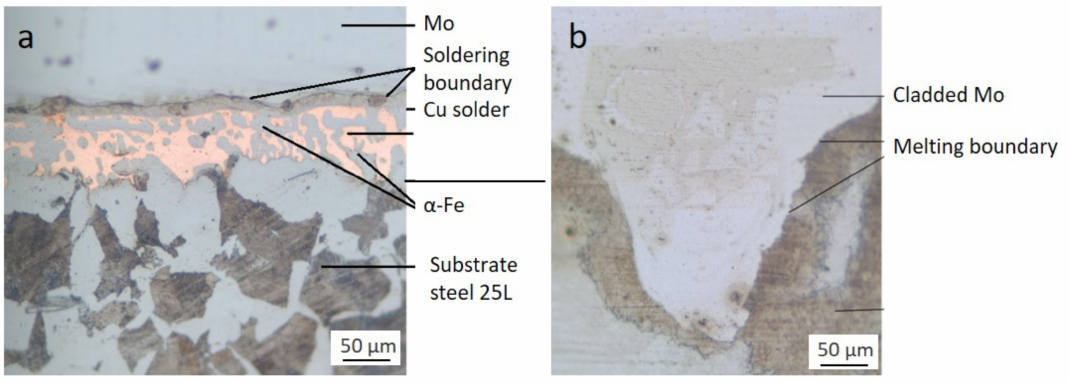
Figure 8. ( a ) Seam microstructure in vacuum brazing; ( b ) LDED according to preferential